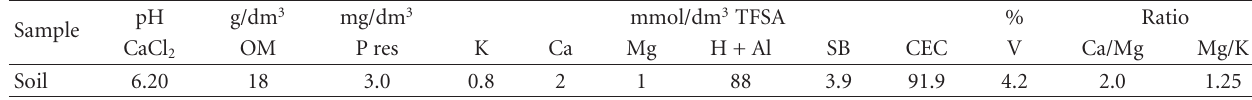
Table 1: Fertility parameters of the control soil.